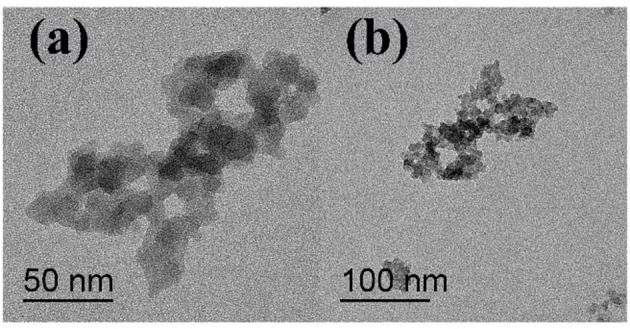
TEM image of NS–NR2 (the scale bars in a is 50 nm and b is 100 nm).